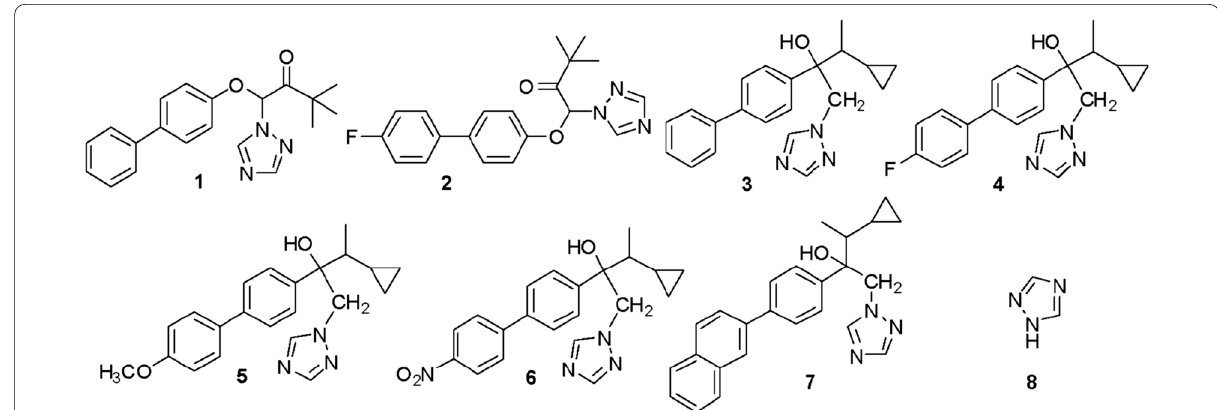
Fig. 2 Chemical structures of compounds